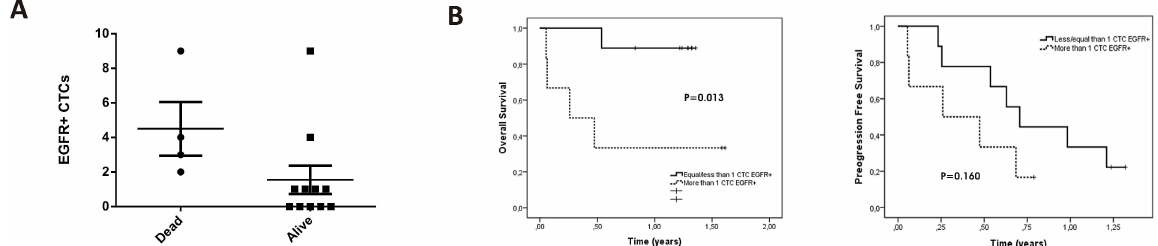
Fig 6. EGFR-positive CTCs correlates with worse prognosis. A) EGFR-positive CTC enumeration from patients with colon, prostate and breast metastatic cancer (from Table 3); (Spearman rank correlationcoefficient = 0.575, p < 0.05). B) Kaplan–Meier plot of overallsurvival or progression free survival based on EGFR-positive CTCs